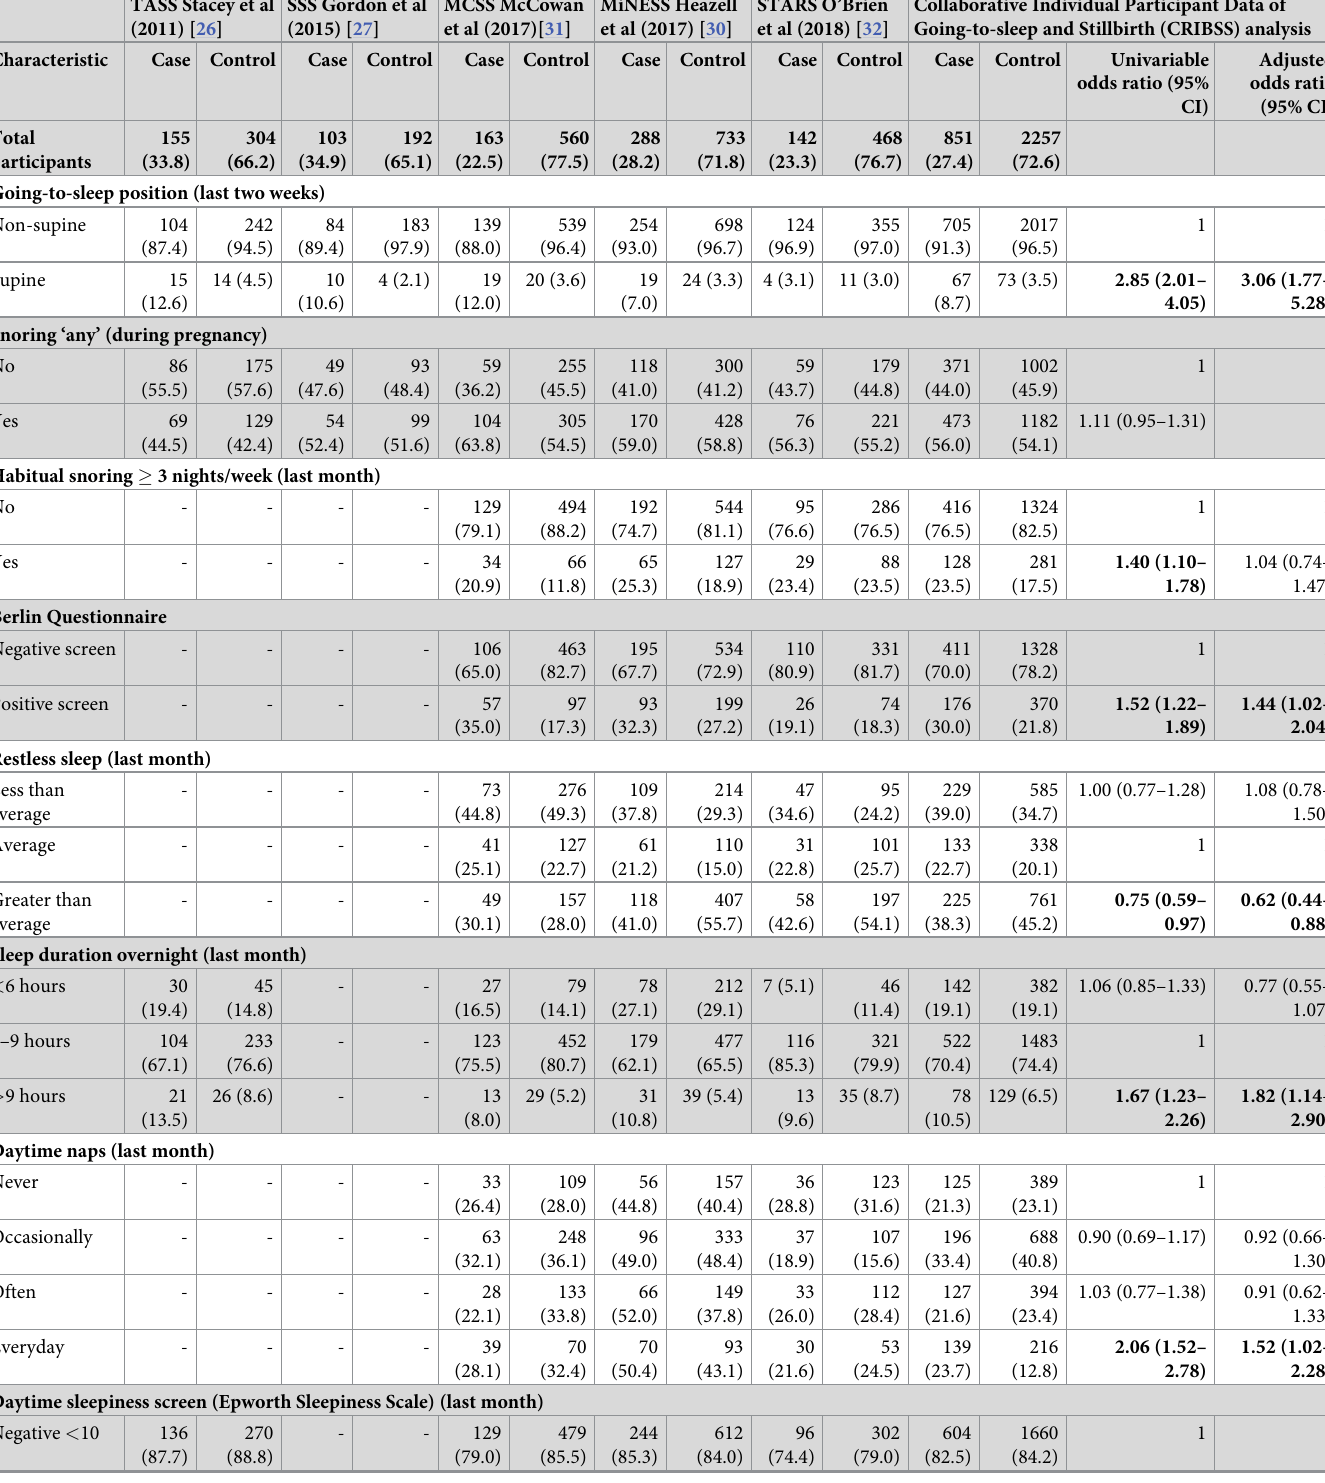
Table 2. Subjective indicators of sleep-disordered breathing and maternal sleep patterns in participating case-control studies and pooled IPD meta-analysis. TASS Stacey et al (2011)